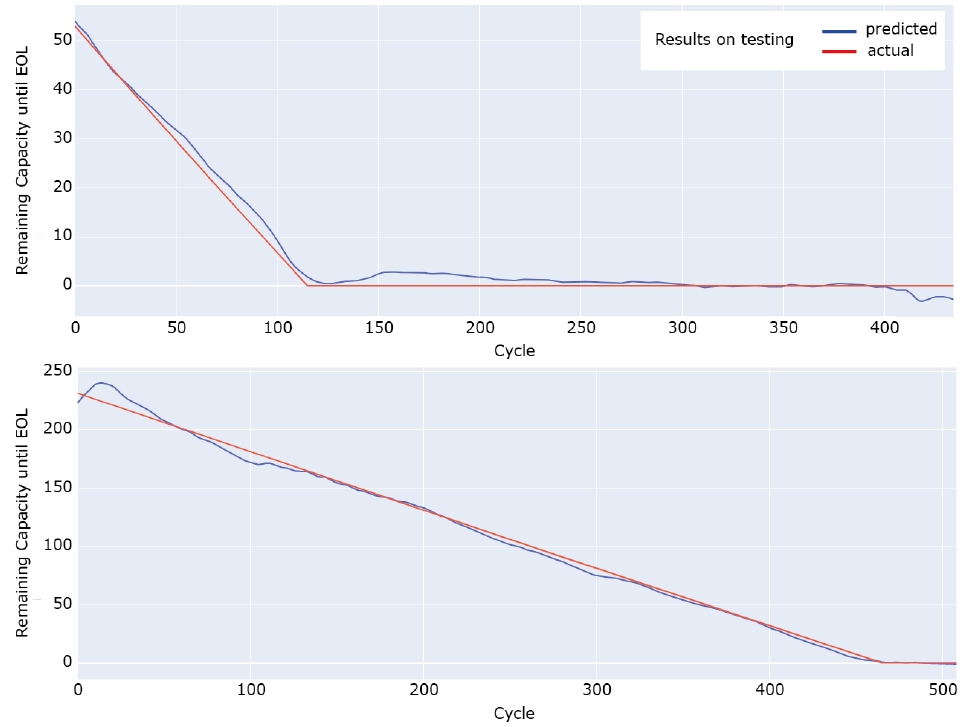
Figure 5. An example of test results of the LSTM ah-RUL prediction on the UNIBO Powertools